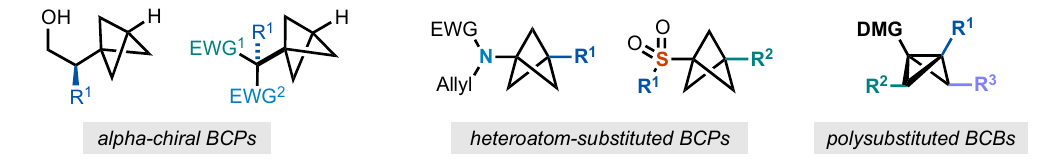
Figure 1. Bicyclic hydrocarbons of interest in Medicinal Chemistry research.